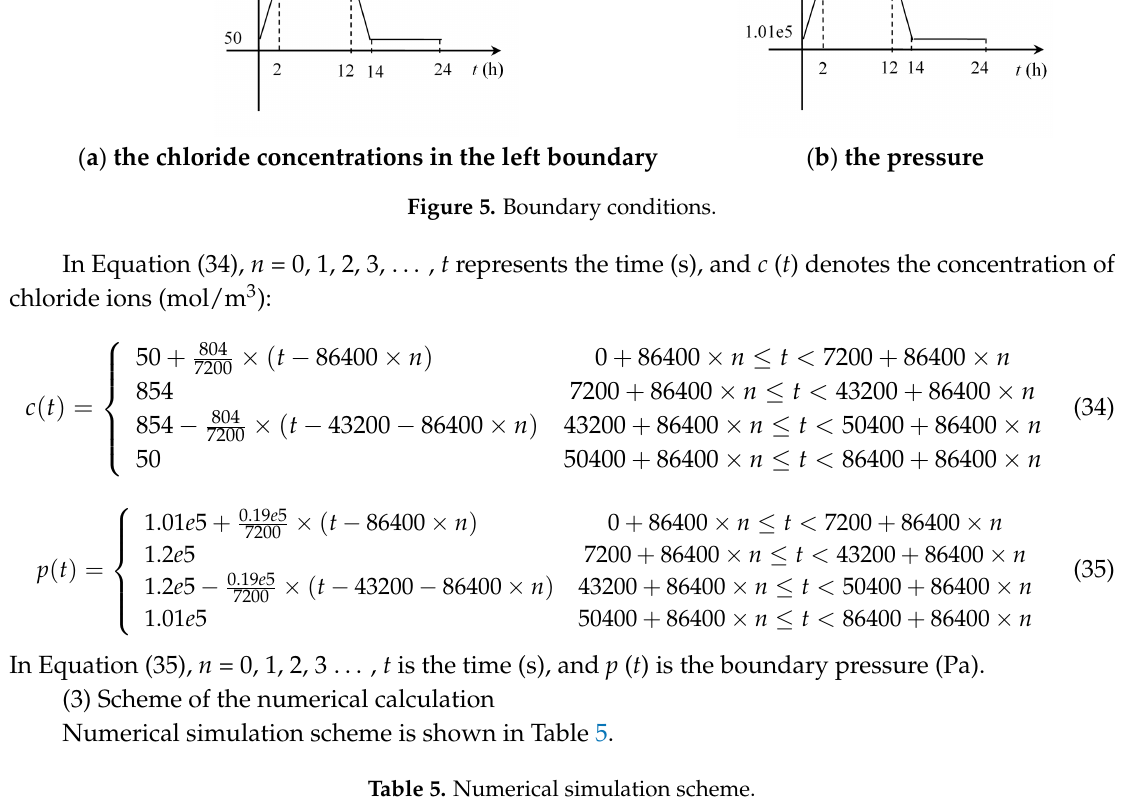
Table 5. Numerical simulation